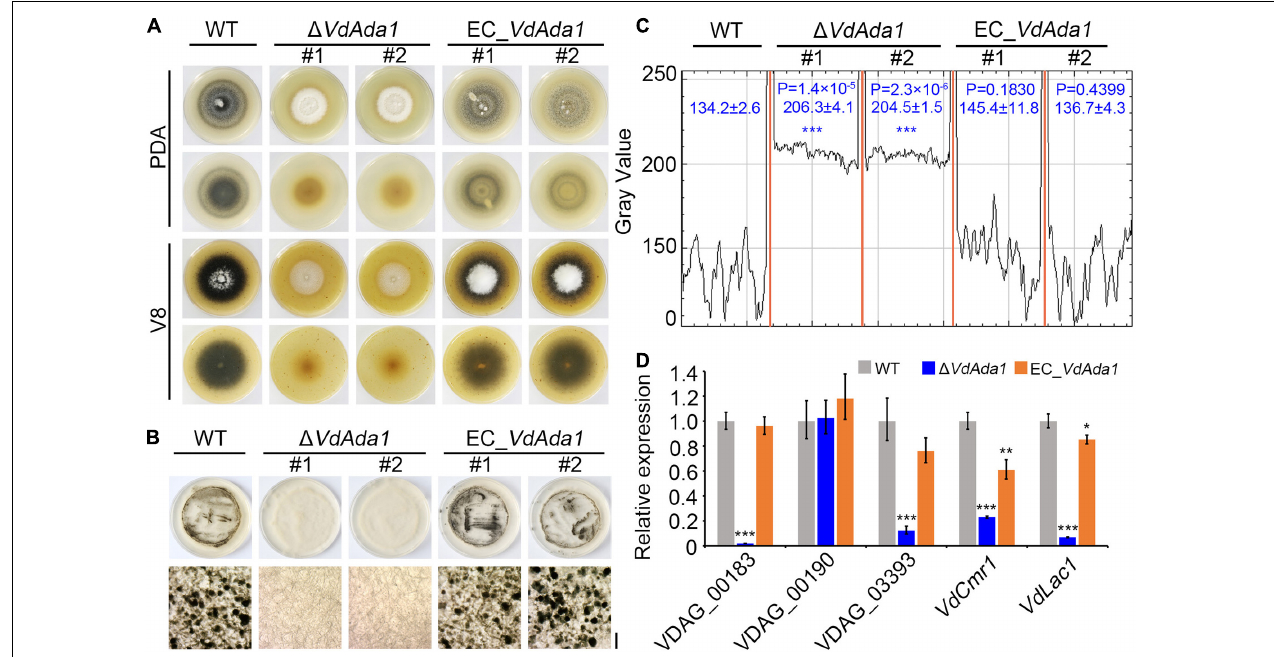
FIGURE 3 | VdAda1 is involved in melanin synthesis and microsclerotia formation in Verticillium dahliae . (A) Colony morphology of the wild type (AT13), (cid:49) VdAda1 , and EC_ VdAda1 strains on PDA and V8 medium plates at 2 weeks post-incubation. (cid:49) VdAda1 strains show reduced melanin production, and mutant complementation restored wild type morphology. (B) The conidial suspensions of the wild type, (cid:49) VdAda1 , and EC_ VdAda1 strains were adjusted to 1 × 10 6 propagules/ml and coated on BMM medium overlaid with cellophane layer. After 2 weeks incubation at 25 ◦ C, the appearance of microsclerotia on the cellophane layer were observed and photographed by stereo microscopy (Below). Scale bar = 20 µ m (C) Gray-value curves were obtained by scanning microscopy photographs of microsclerotia in (B) using ImageJ software. The numbers indicate the range of gray values of each strain. The asterisks show significant differences (*** P < 0.001) compared with the wild type using one-way analysis of variance (ANOVA). (D) VdAda1 regulates the expression of melanin-associated genes. RT-qPCR was used to measure expression levels of melanin-associated genes in the wild type, (cid:49) VdAda1 , and EC_ VdAda1 strains cultured on BMM medium overlaid with a cellophane membrane for 2 weeks. The V. dahliae elongation factor 1- α ( VDEF-1 α ) was used as an endogenous control for RT-qPCR. Error bars represent the standard deviation calculated from three replicate experiments, and the asterisks indicate significant treatment differences (*** P < 0.001, ** P < 0.01, and * P < 0.05, respectively) in expression compared with the wild type using one-way analysis of variance